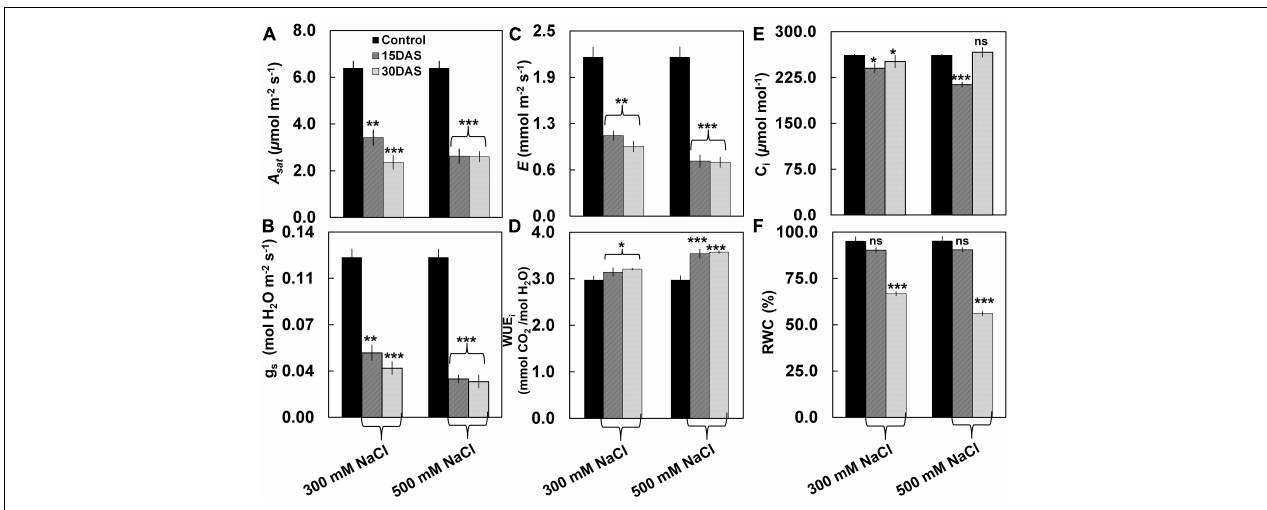
FIGURE 2 | Effect of salinity stress on leaf photosynthetic performance of P. pinnata . Variations in (A) light-saturated net photosynthetic rate ( A sat ) ( µ mol m − 2 s − 1 ), (B) stomatal conductance (